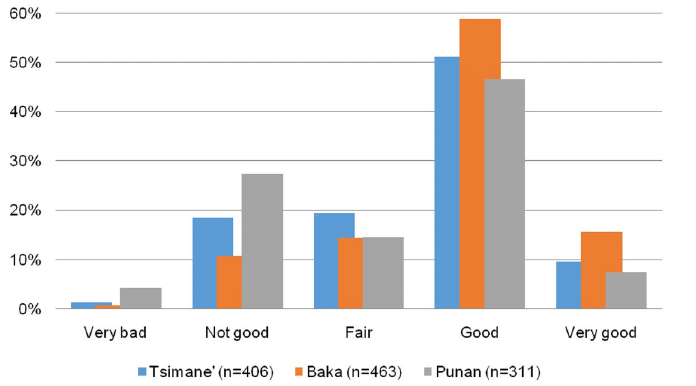
Fig 1. Distribution of life satisfaction level responses, percentage by society.